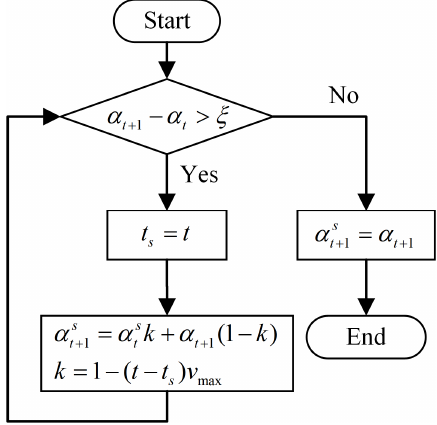
Figure 10. Flow chart of trajectory-smoothing process. The smoothened trajectory of the rotation angle is shown as the black dashed line in Figure 9a. The smoothened trajectory replaced the original trajectory at the singularity, which restored the original trajectory tracking in a short time. By smoothing the trajectory of the rotation angle at the singularity, Cartesian control could be realized. It can be also seen in Figure 9a that the trajectory of the rotation angle had abrupt changes at − π and π , which also caused the motor driver to malfunction. The abrupt changes at −π and π can be explained by Equation (5). To prevent the motor driver from malfunctioning, we restricted the rotation angle range of the manipulator. In Figure 9b, the green transparent area represents the range of the rotation angle of the manipulator. x sl y sl z sl and x sr y sr z sr denote the left-manipulator and right-manipulaotr coordinate systems established at the end of the endoscopic channel, respectively; the x sl y sl z sl coordinate sys- tem followed the left-hand rule and the x sr y sr z sr coordinate system followed the right-hand rule. The z sr -axis and z sl -axis are pointing inward perpendicular to the paper in the figure. The manipulator of the transluminal endoscopic surgery robot mostly worked in a dual- manipulator collaborative mode [10–15] and did not need to operate the part outside the limited area. At the same time, the part outside the constrained area was in the blind zone of the endoscope’s visual field. The restricted range of rotation angle had no effect on the actual operation. 4. Experiments and Results The power transmission between the transmission system and the manipulator was carried out by the tendon–sheath system. The tendon would elastically elongate due to the friction and tension; the elongation was related to the total bending angle of the sheath. To ensure the movement accuracy of the manipulator, we compensated the elastic elongation of the cable [25]. 4.1. T rajectory-Tracking Experiment In this section, the performance of manipulator trajectory tracking is evaluated. An experimental setup was built to verify the trajectory-tracking performance when the manipulator was operated in a Cartesian control mode. The experimental setup is shown in Figure 11a. The motors of the driver system were driven by the digital controller (G- SOLTWI6/100EE01 from Elmo Group), and the digital controller was connected to an industrial computer (C6920 from Beckhoff Group) by the Ethercat (Controller Area Network) bus. A teflon tube with an inner diameter of 4 mm was fixed on the test bench by a bracket. The manipulator could be freely bent and rotated through the Teflon tube. An electromagnetic tracking system (resolution: 0.001 mm; VIPER 4, Polhemus Ltd., Vermont, USA) was used to measure the trajectory of the manipulator. The electromagnetic (EM) sensor (diameter: 1.8 mm) was mounted on the end of the